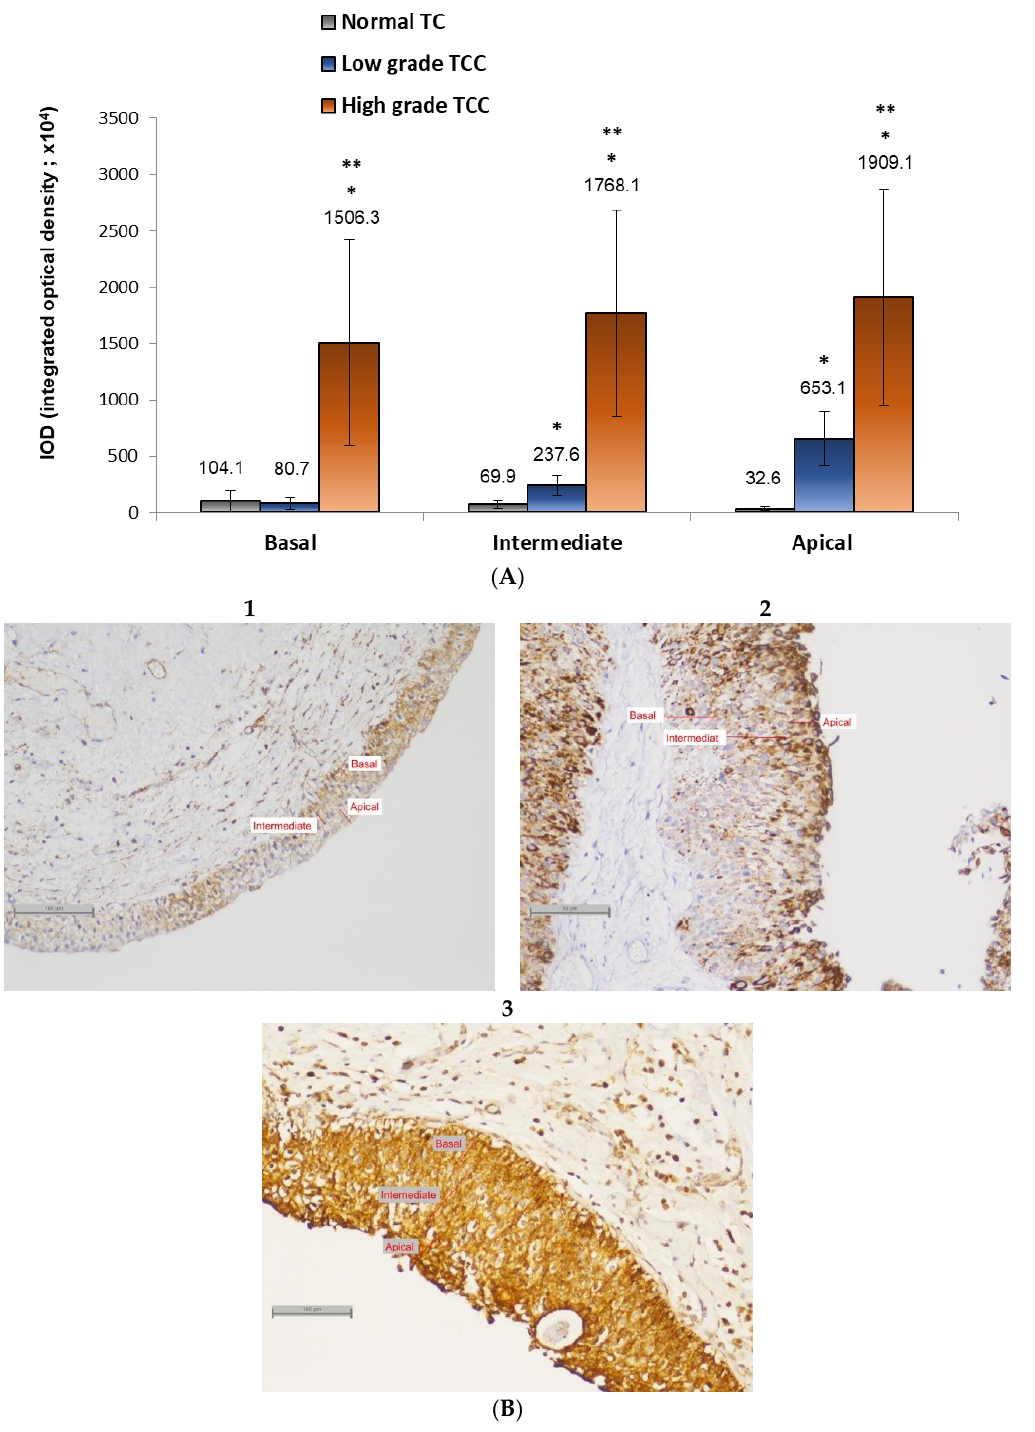
Figure 2. Expression of semaphorin 3A in UC. Immunohistochemical staining of high grade, low grade, and normal TC samples were analyzed for semaphorin 3A expression in basal, intermediate and apical layers of epithelium. Image analysis of repetitive pictures of epithelium sections was conducted ( A ). Three of the pictures are exhibited in ( B ) (1—Normal; 2–Low grade UC; 3—High-grade UC). Asterisks mark statistical significance ( p < 0.05): * Performance vs. Normal; ** Performance vs. Low grade UC (×100).